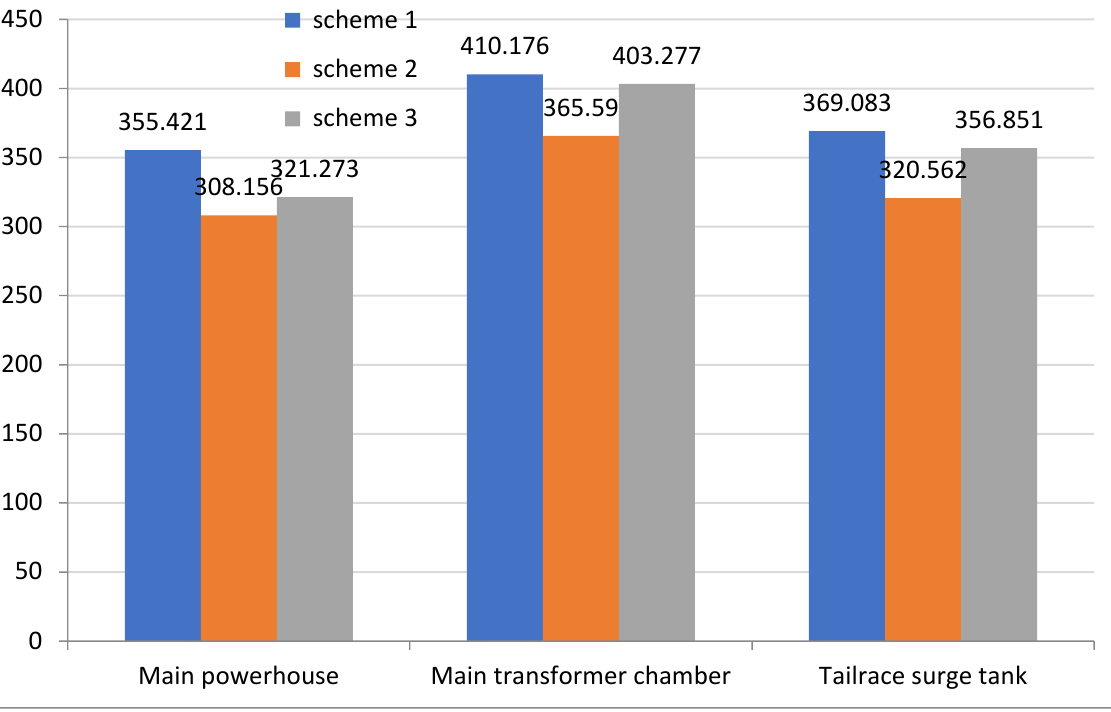
Figure 15. Vertical displacement of bottom floor of cavern group in three schemes after excavation (mm).